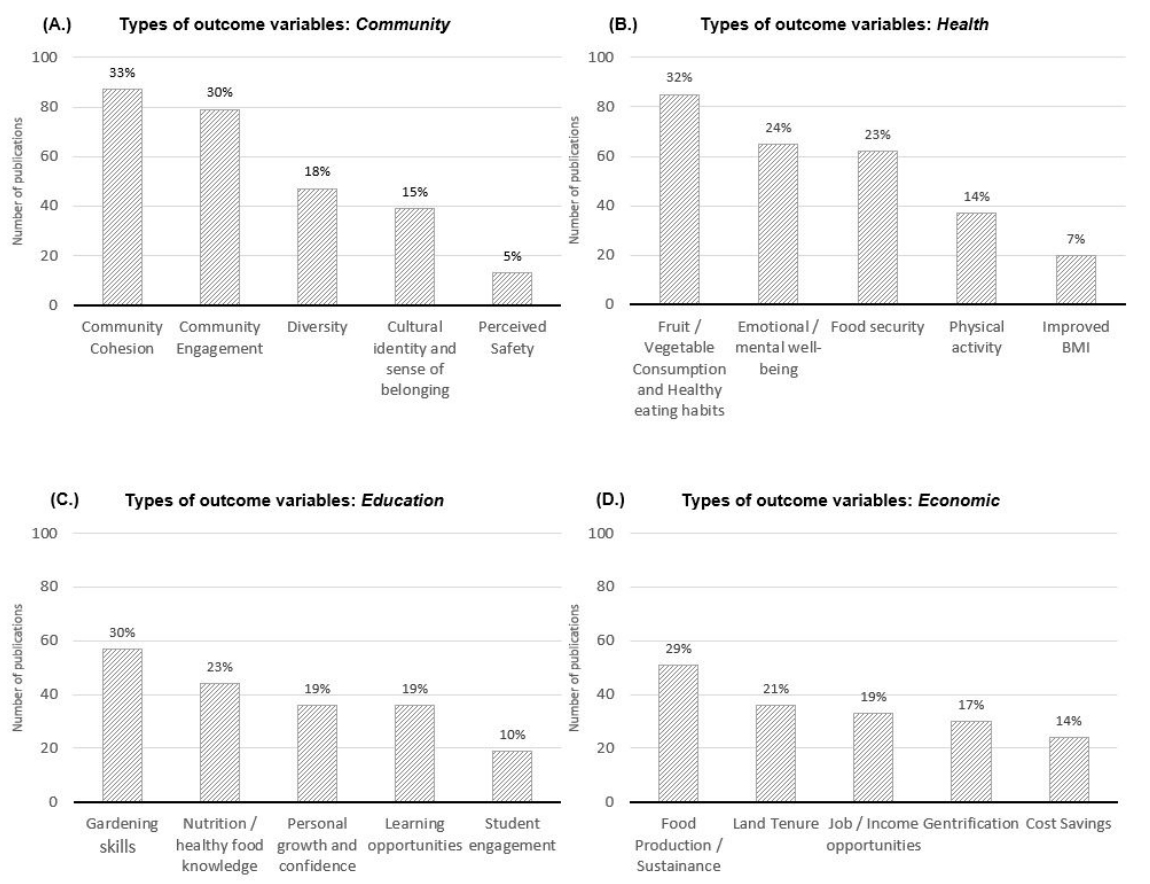
Figure 6. Types of socio-cultural outcome variables considered by category: ( A .) Community; ( B .) Health; ( C .) Education; ( D .) Economic. Note: Because papers often used more than one outcome variable to measure the benefits of urban agriculture, the total number of publications represented in this figure exceeds the total number of unique papers part of the sample of publications ( n = 272) analyzed in this paper.